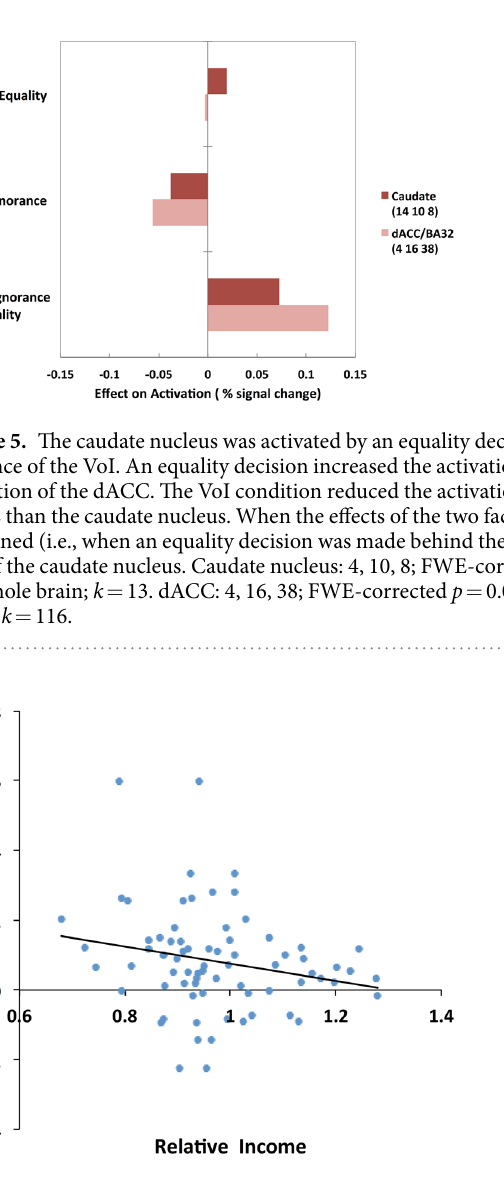
Figure 6. Activation in the caudate nucleus was correlated with expected reward. Activation of the caudate nucleus (14, 10, 8; FWE-corrected p = 0.029 for multiple comparisons across the whole brain; k = 13) was negatively correlated with relative income ( r = − 0.21, p = 0.019) when choosing an equality rule behind the VoI. Neural data were obtained from the contrast that subtracted the activation evident when drawing the lottery from that observed upon a redistributive decision. The relative income was calculated by dividing the participant’s total income by that of the partners. Total income was neither realized nor revealed until the end of the game; thus, the relative income was regarded as an expected